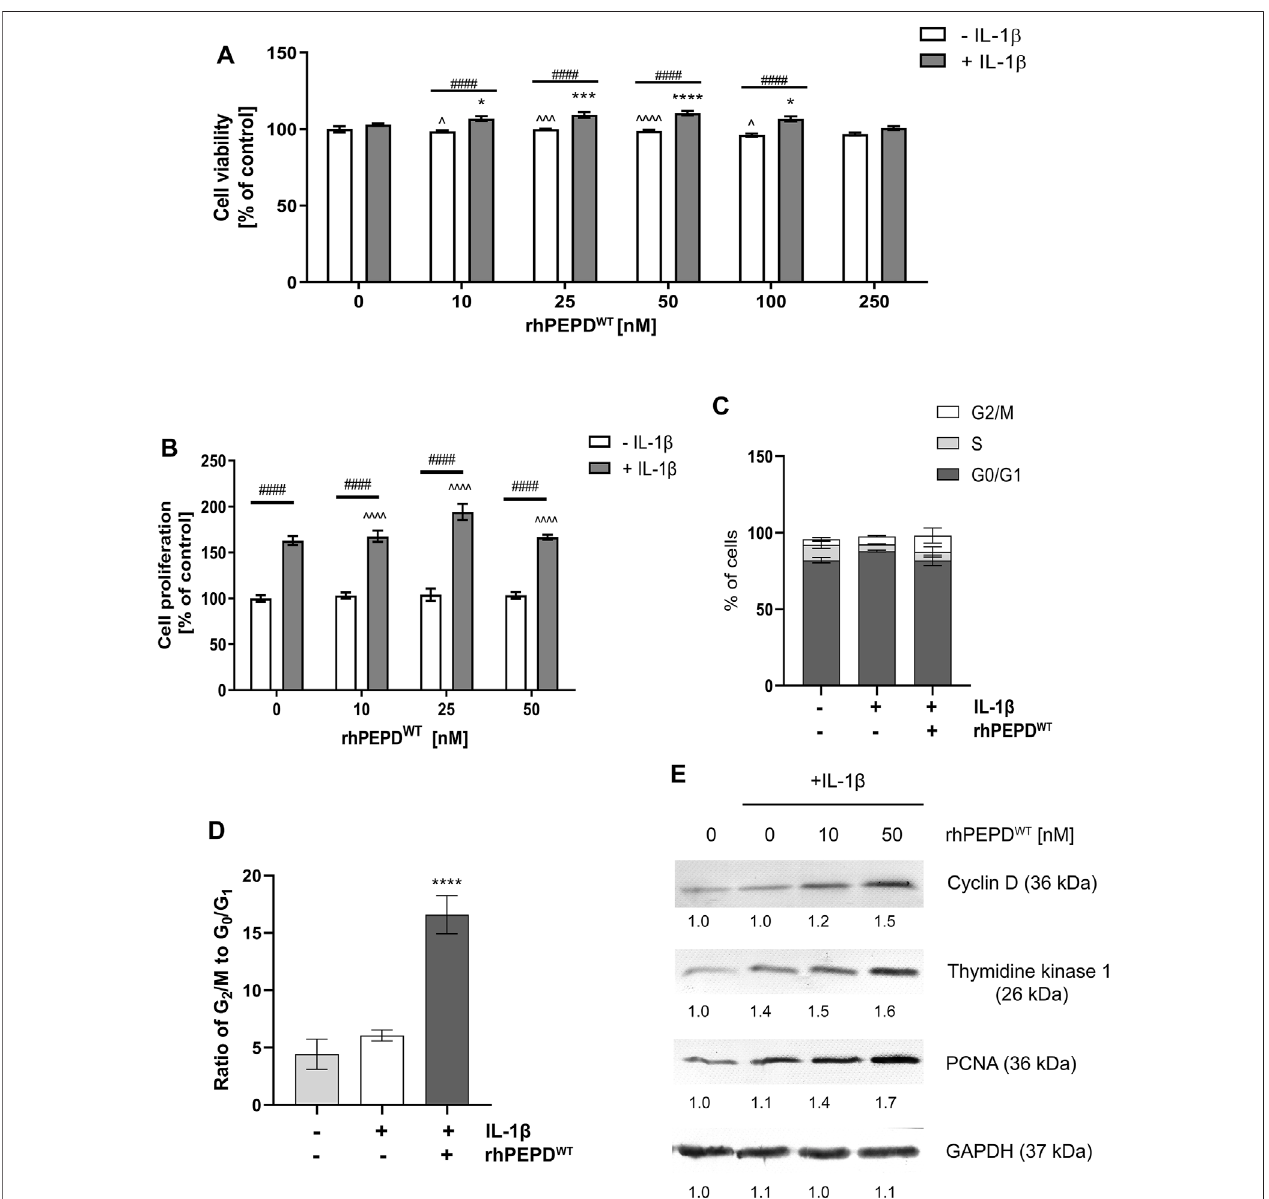
FIGURE1| Human recombinantprolidase(rhPEPD WT ,10 – 250 nM)augmentsIL-1 β (10 ng/ml)-inducedcellproliferationinHaCaTcells: (A) Cellviabilitymeasured bythemetaboliccapacityofmitochondria; (B) cellproliferationmeasuredasthelevelofincorporated fl uorescentdyeinDNA; (C) thepercentageofcellsinG 0 /G 1 ,S,and G 2 /M phases using DNA content-based cell analysis; (D) the ratio of G 2 /M to G 0 /G 1 phase using DNA content-based cell analysis; (E) Expression of the selected cell- cycleregulatoryproteins.Thedataarepresentedasthemean±SD, n =3ineachgroupandcomparedtothecontrolgroup.Representativeblotimagesareshown (densitometry of protein stains is presented under protein bands as a ratio versus control; Supplementary Figure S1 ). GAPDH was used as loading control. Statistical signi fi canceswereexpressed as*, ^ , # p < 0.05, **, ^^ , ## p < 0.01, ***, ^^^ , ### p < 0.001and ****, ^^^^ , #### p < 0.0001;indicates*vs. control(0 nMofPEPD,withoutIL-1 β )cells, ^ vs. control (0 nM of PEPD, with IL-1 β ) cells, # signi fi cance between groups treated with or without IL-1 β , respectively.